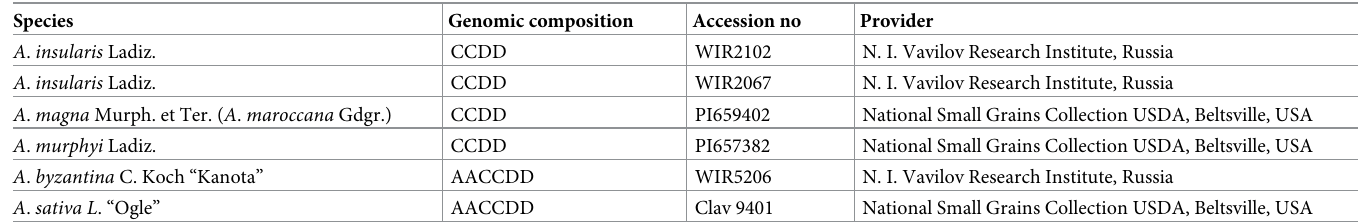
Table 1. Plant material used in the present